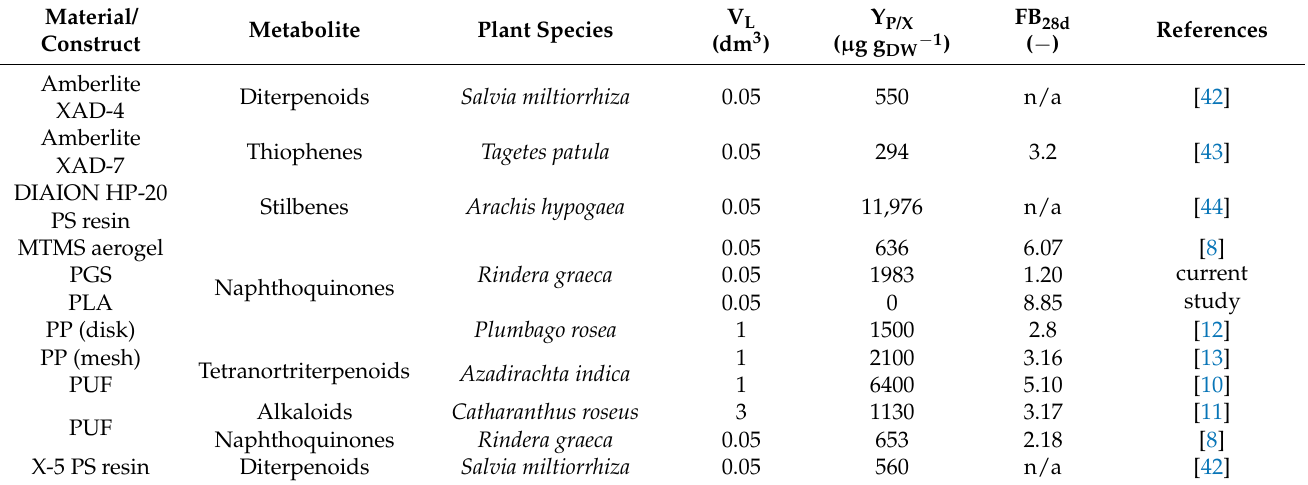
Table 3. Previously published data on materials applied for the immobilization of hairy